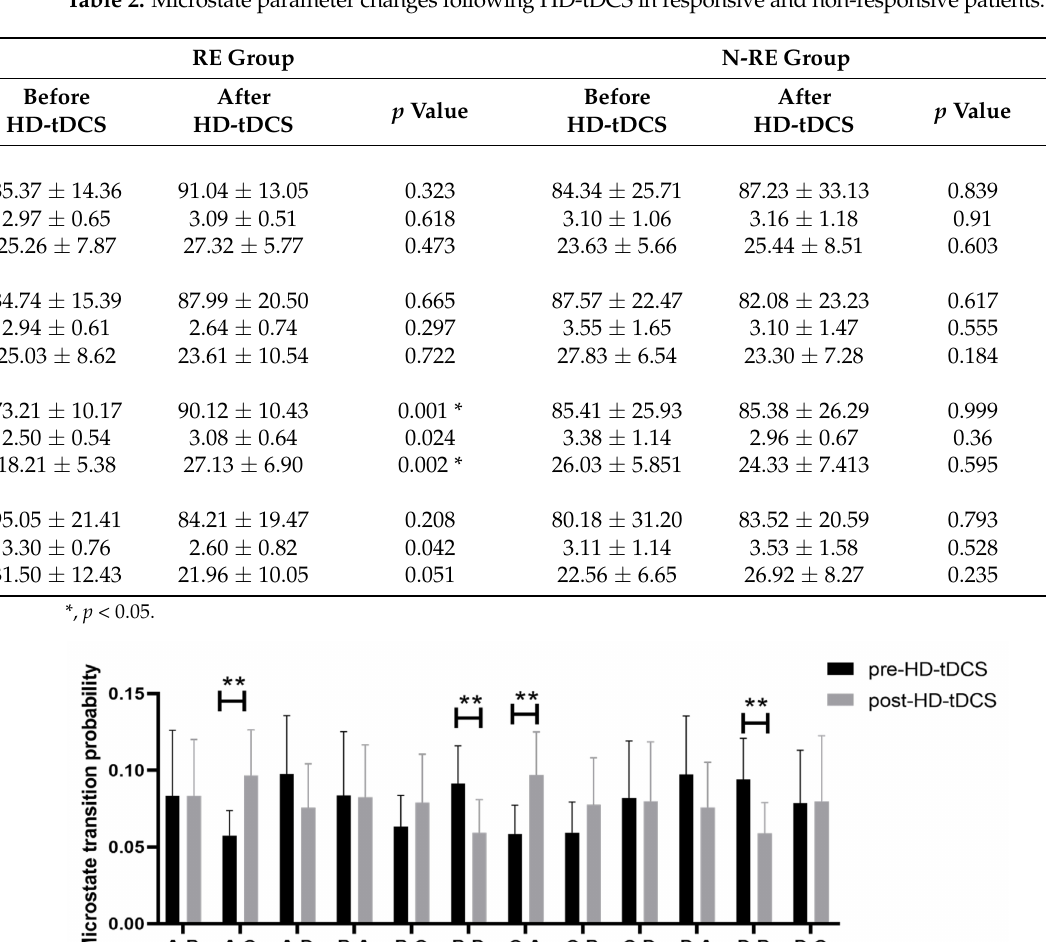
Figure 5. Syntax of microstate class concatenation changes induced by HD-tDCS in the responsive group. (** p <